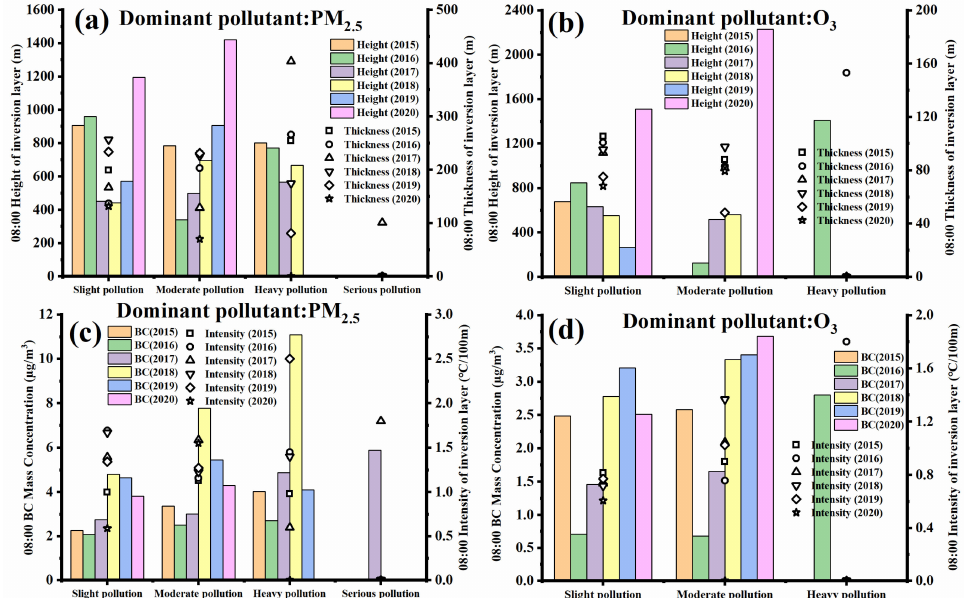
Figure 5. ( a ) Annual variations in inversion layer height and inversion layer thickness at 08:00 for